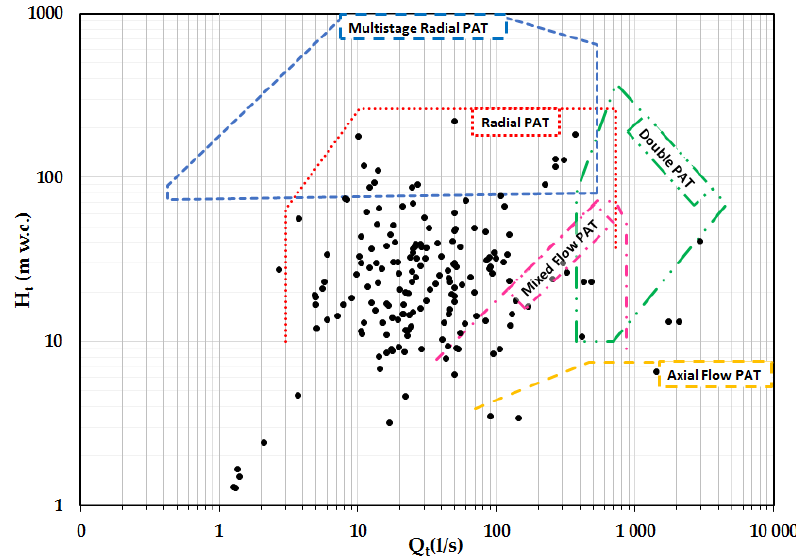
Figure 1. Characteristics curves in a pump working as a turbine (PAT).